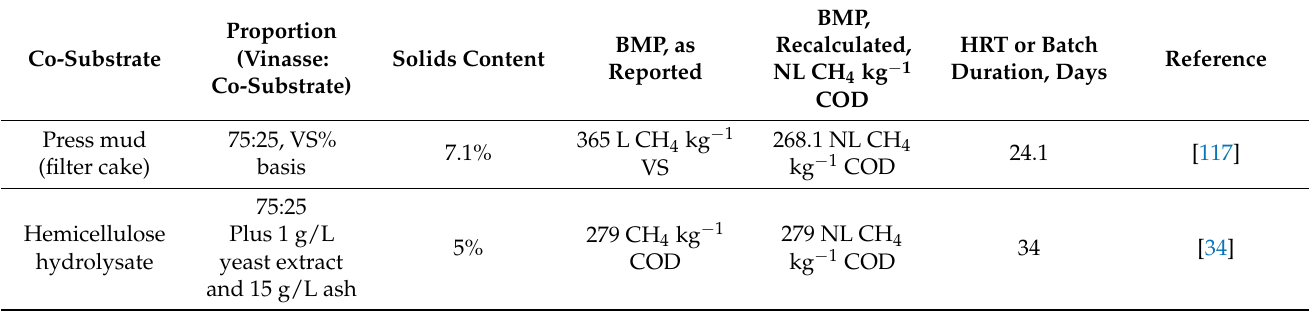
Table 2. Biochemical methane potential, BMP, in vinasse